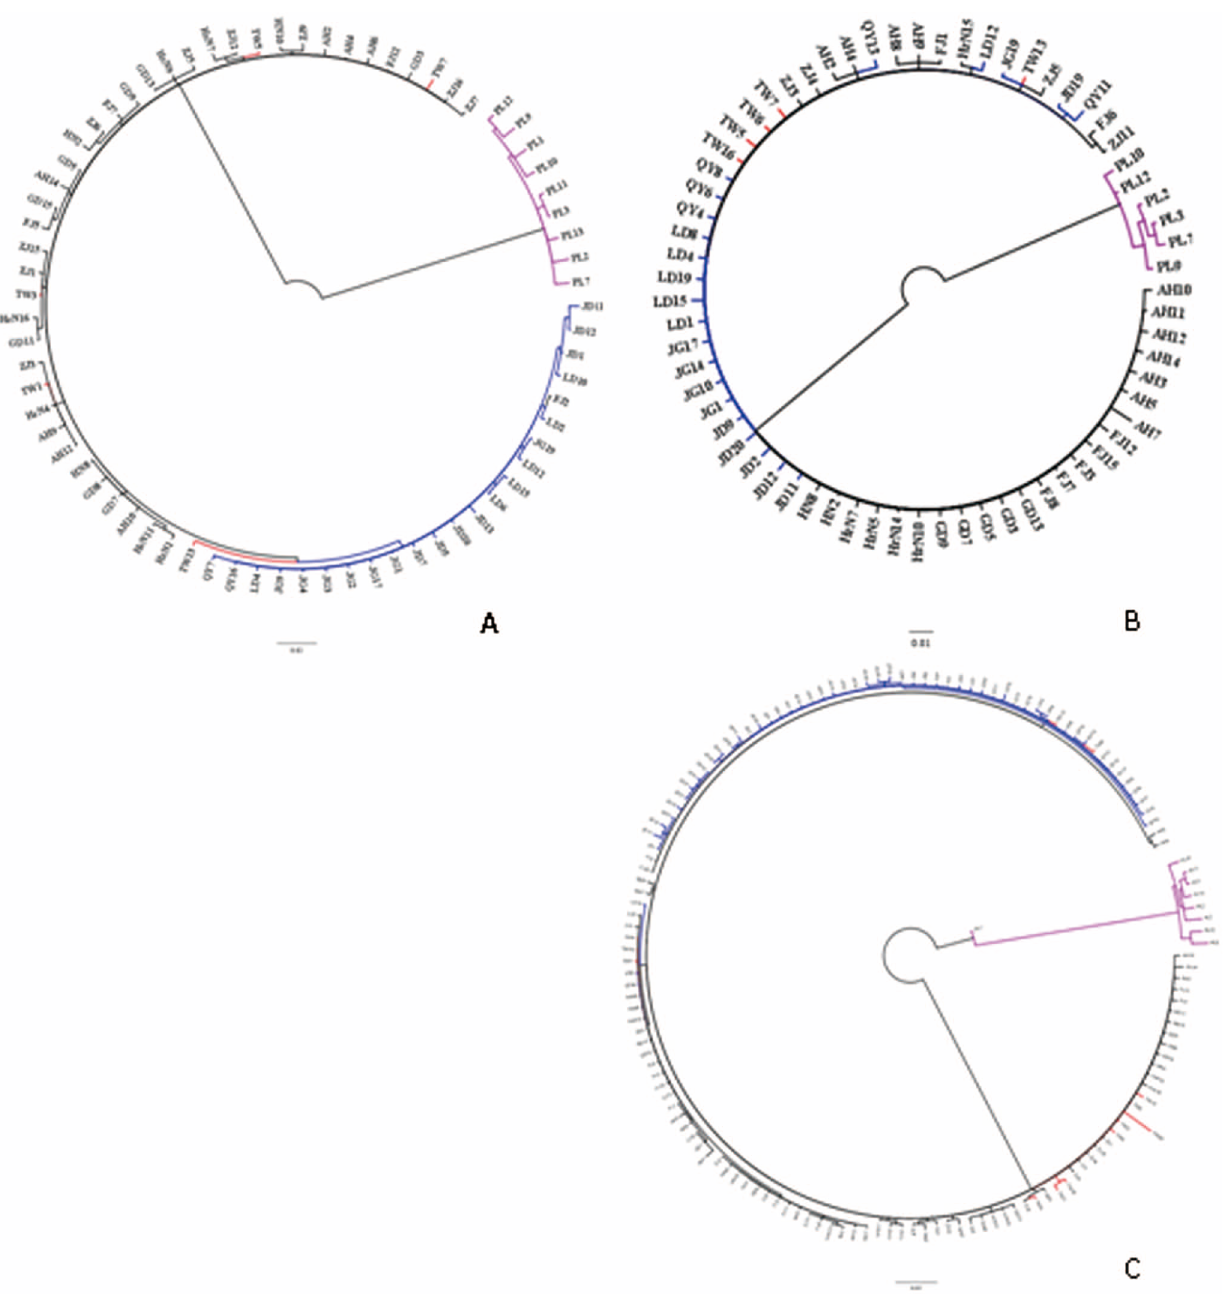
Fig. 2. The BI phylogenetic trees for COI (A), 16sRNA (B) and combined sequences (C) of eleven leafhopper populations from Mainland China, Taiwan and Japan. The samples from Mainland China, Japan and Taiwan were shown with black, blue and red colour, respectively; and the out-group of E. flavescens was shown with purple colour. These analyses involved 73, 67 and 149 nucleotide sequences including the out-group, respectively. Evolutionary analyses were conducted using MrBayes 3.2.2.